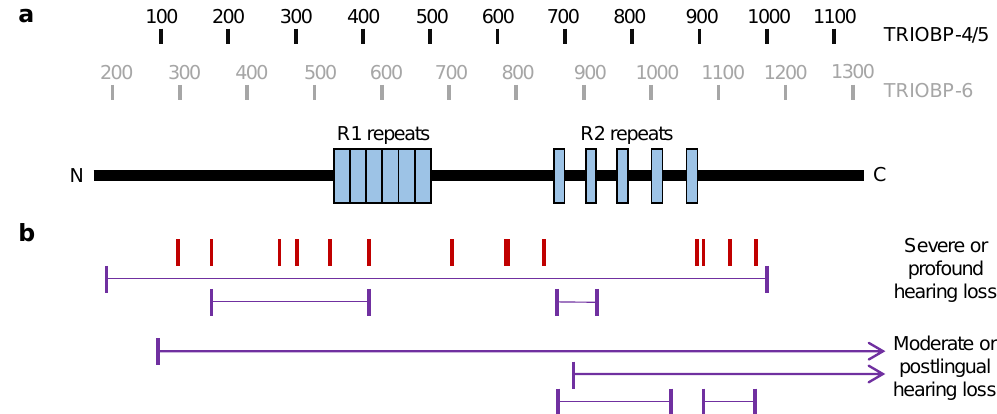
Figure 4. ( a ) The location of the repeats that make up the R1 and R2 regions of TRIOBP-4, with ¸amino acid numbering of both TRIOBP-4 / 5 and TRIOBP-6. ( b ) The location of frameshift and nonsense mutations from patients with hearing loss. Red bars indicate homozygous mutations, while purple bars joined by dotted lines indicate compound heterozygous mutations. Arrowheads indicate that the other heterozygous mutations lie in a region of TRIOBP-5 / 6 that is 3 (cid:48) of the TRIOBP-4 open reading frame. Full details of these are in Table 1. All elements of this figure are shown to